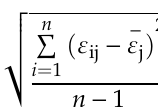
Table 3. Accuracy comparison.